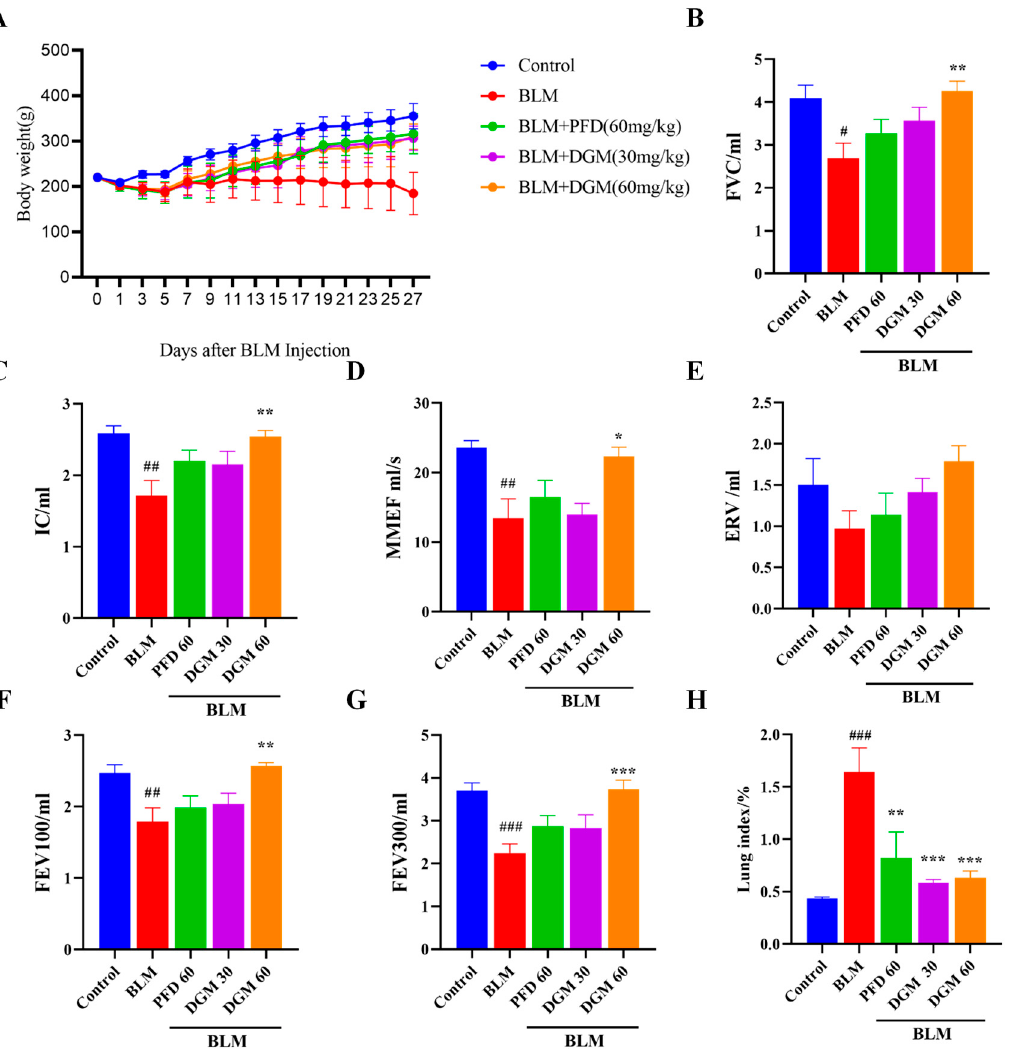
Figure 4. DGM improves BLM-induced weight loss and decreases lung function in rats. ( A ) Body weight records of rats in the control group, the bleomycin (BLM) group, the PFD group, the DGM (30 mg/kg), and DGM (60 mg/kg) groups throughout the experiment. ( B – G ) Pulmonary function indicators: forced vital capacity (FVC), deep inspiratory volume (IC), maximum mid-expiratory flow (MMEF), supplementary expiratory volume (ERV), forced expiratory volume (FEV). ( H ) Lung coefficient: lung weight/body weight. Data represent the mean ± SEM ( n = 6). # p < 0.05, ## p < 0.01, ### p < 0.001 vs. control group; * p < 0.05, ** p < 0.01, *** p < 0.001 vs. BLM group.